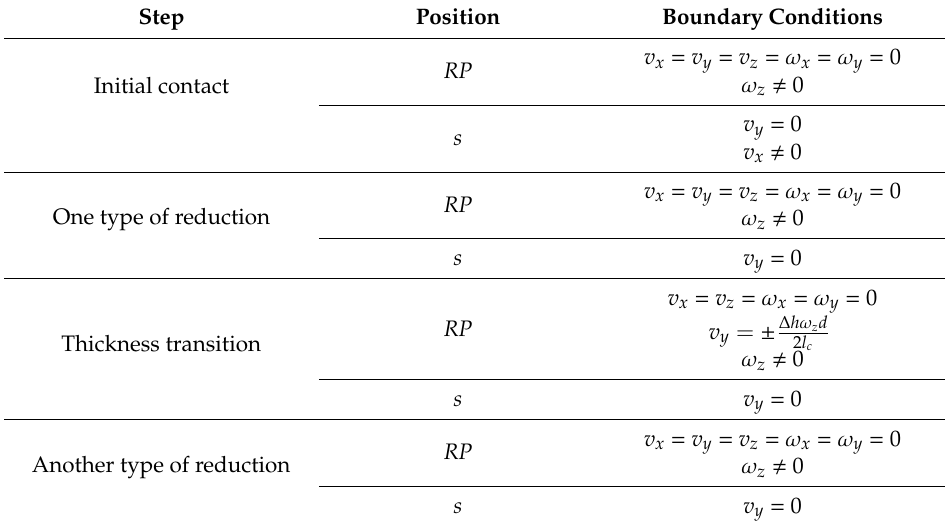
Table 1. Boundary conditions for di ff erent analysis